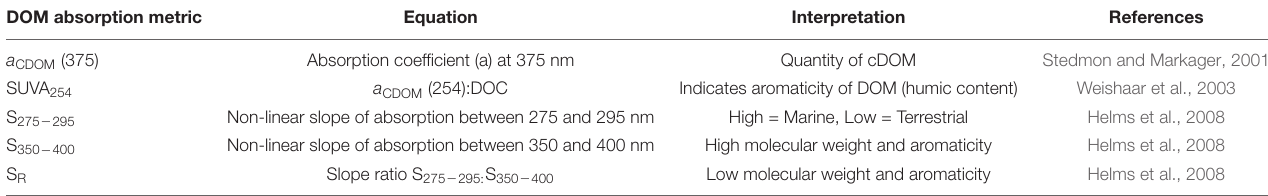
TABLE 1 | Optical characteristics of cDOM based on absorption spectra.